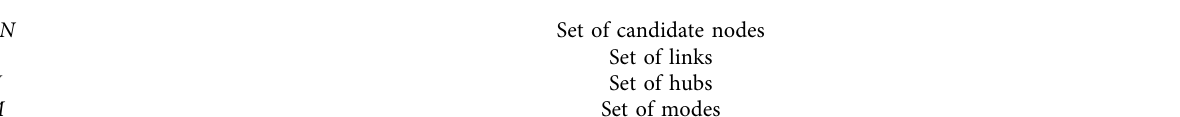
Table 2: Notations of the upper-level